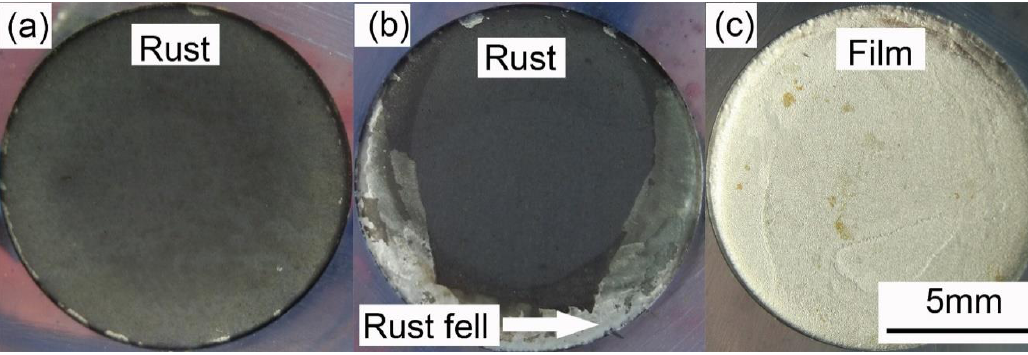
Figure 5. Macro-morphologies of sample surfaces in: Stage 1 (A – B of Figure 4) ( a ); Stage 2 (B – C of Figure 4) ( b ); and Stage 3 (C – D of Figure 4) ( c ).